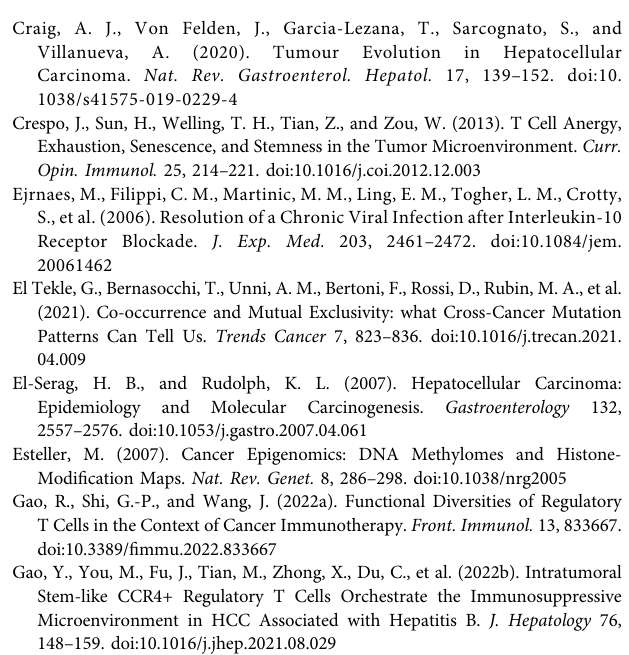
Supplementary Figure S1 | (A) RAB42 expression was positively correlated with IL10 and TGFB1 expression in HCC based on the GEPIA database. (B) The correlation between RAB42 expression and the in fi ltration level of Tregs was investigated by using various algorithms in HCC from the TIMER database. Tregs, regulatory T cells. (C) The table summarized the correlation coef fi cients R and p values of RAB42 and major genes of various stages of T cell exhaustion in HCC based on the GEPIA